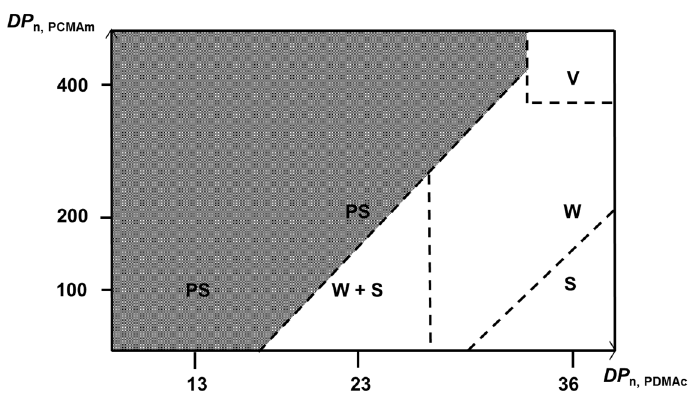
Figure 8. Supposed phase diagram for PDMAm- b -PCMAm diblock copolymers prepared at 10 wt% monomer concentration in water. PS = phase separation, S = spheres, W = worms, V = vesicles.